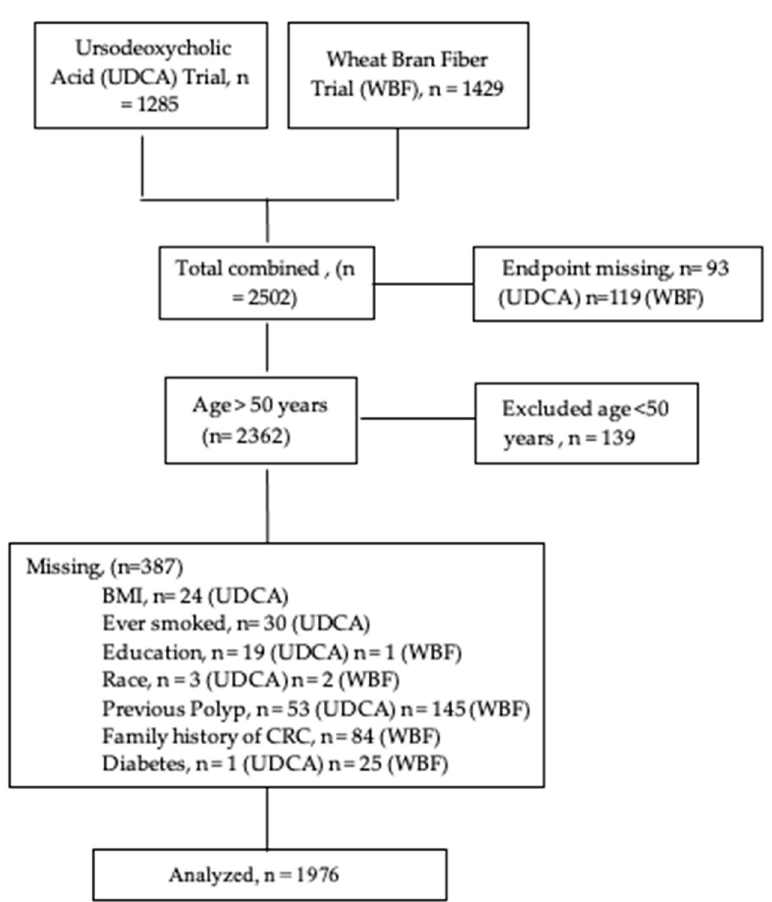
Figure 1. CONSORT Diagram of study participants from the Urosdeoxycholic Acid (UDCA) trial and the Wheat Bran Fiber Trial (WBF). Exclusion criteria from each trial is discussed in the main analysis.